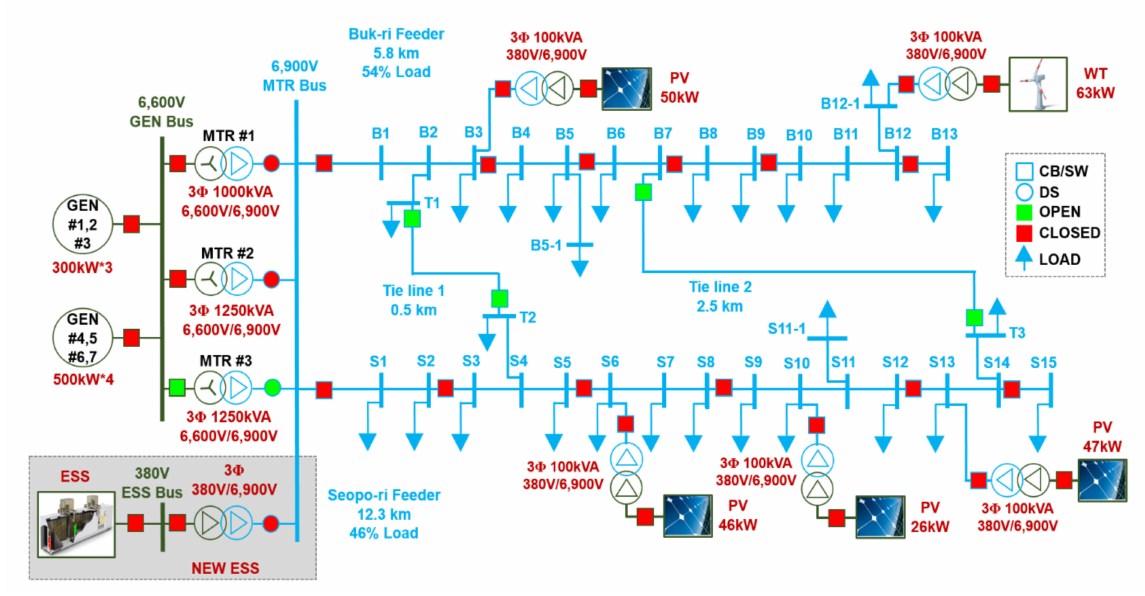
Figure 2. Single line diagram of the current power system of Deokjeok